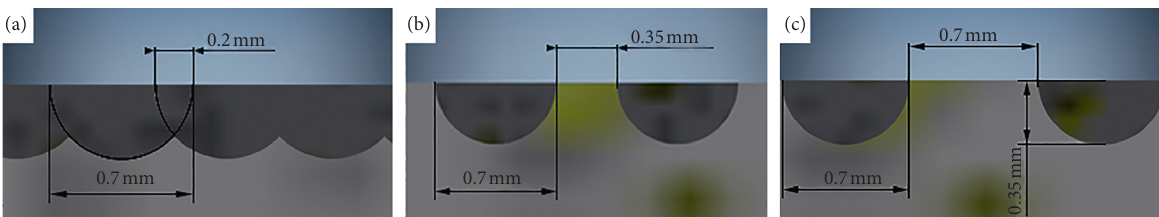
Figure 3: Cross-sectional view of laser-treated zones in Autodesk Inventor software. (a) Case B. (b) Case C. (c) Case D.